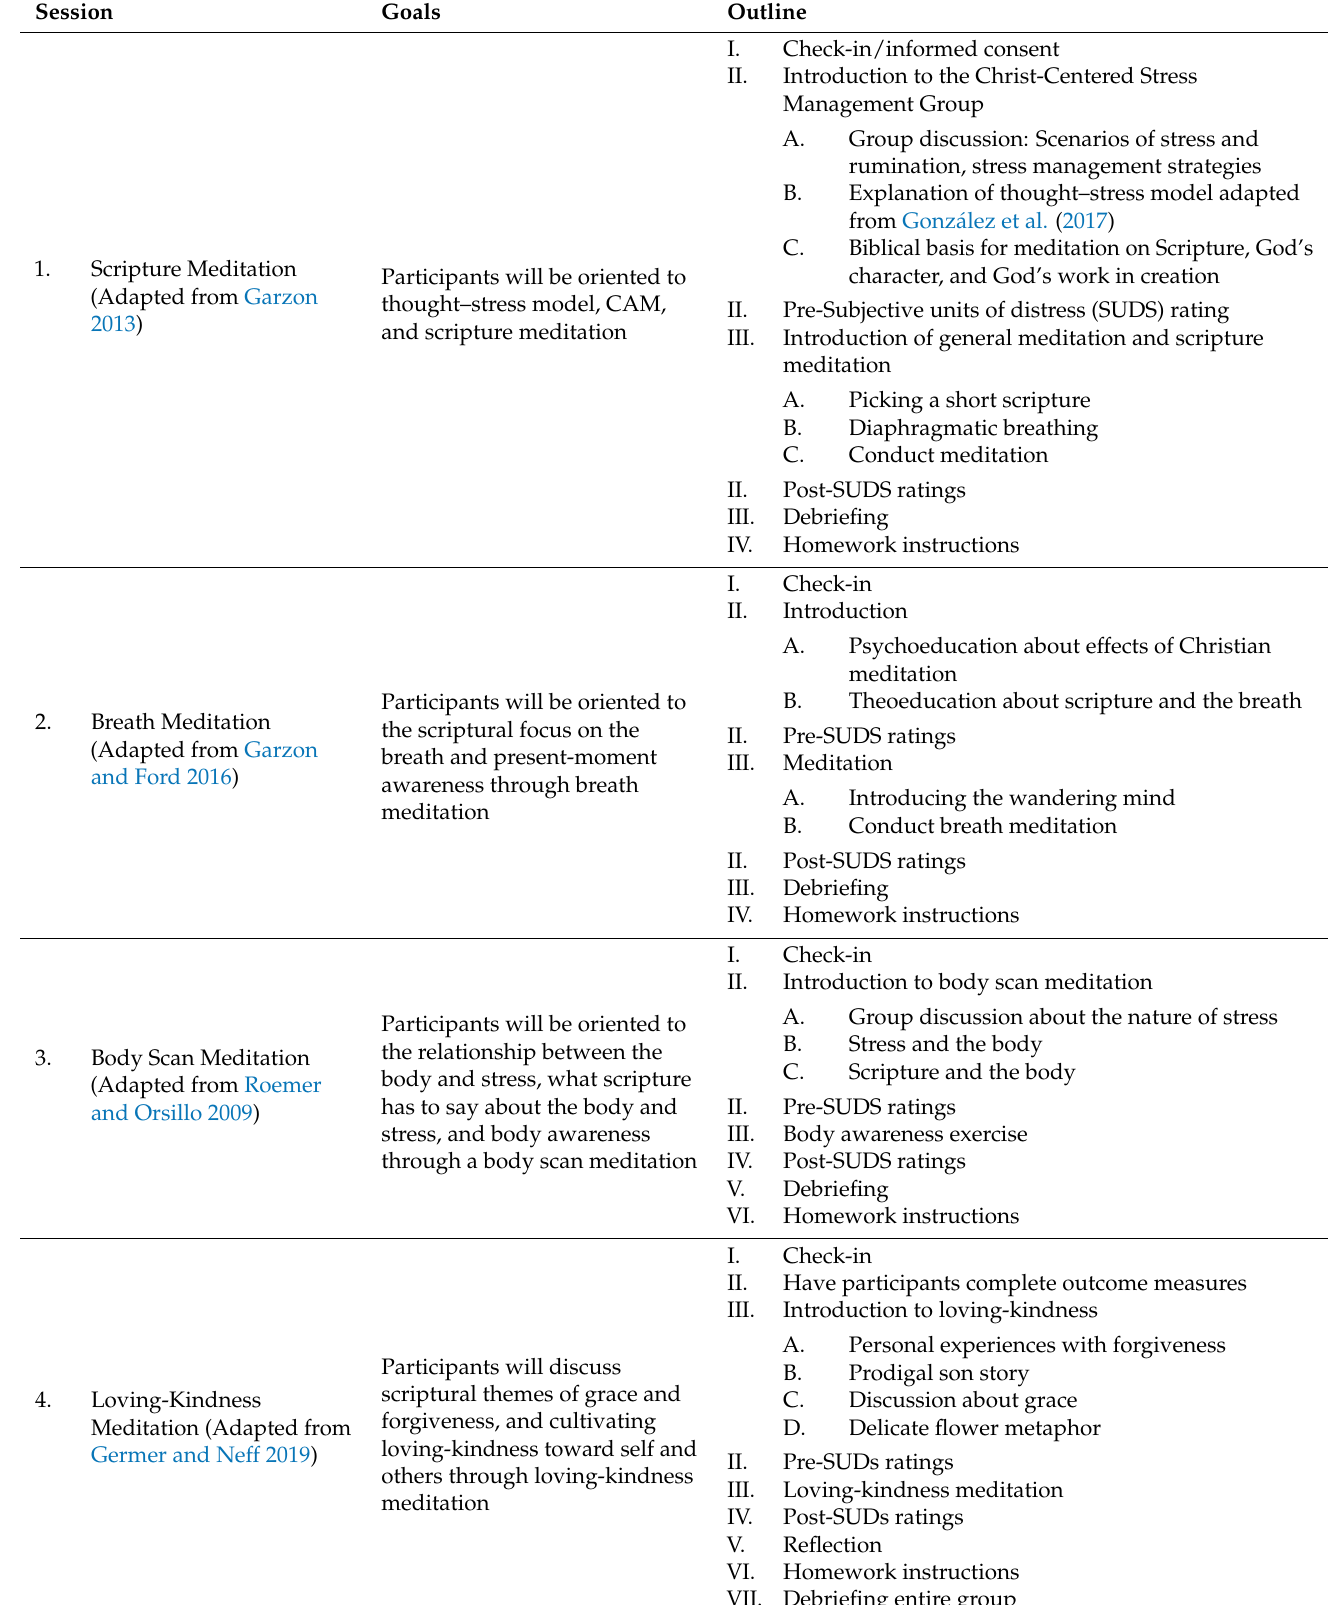
Table 1. Four-week Christian accommodative mindfulness (CAM) group protocol outline. Session